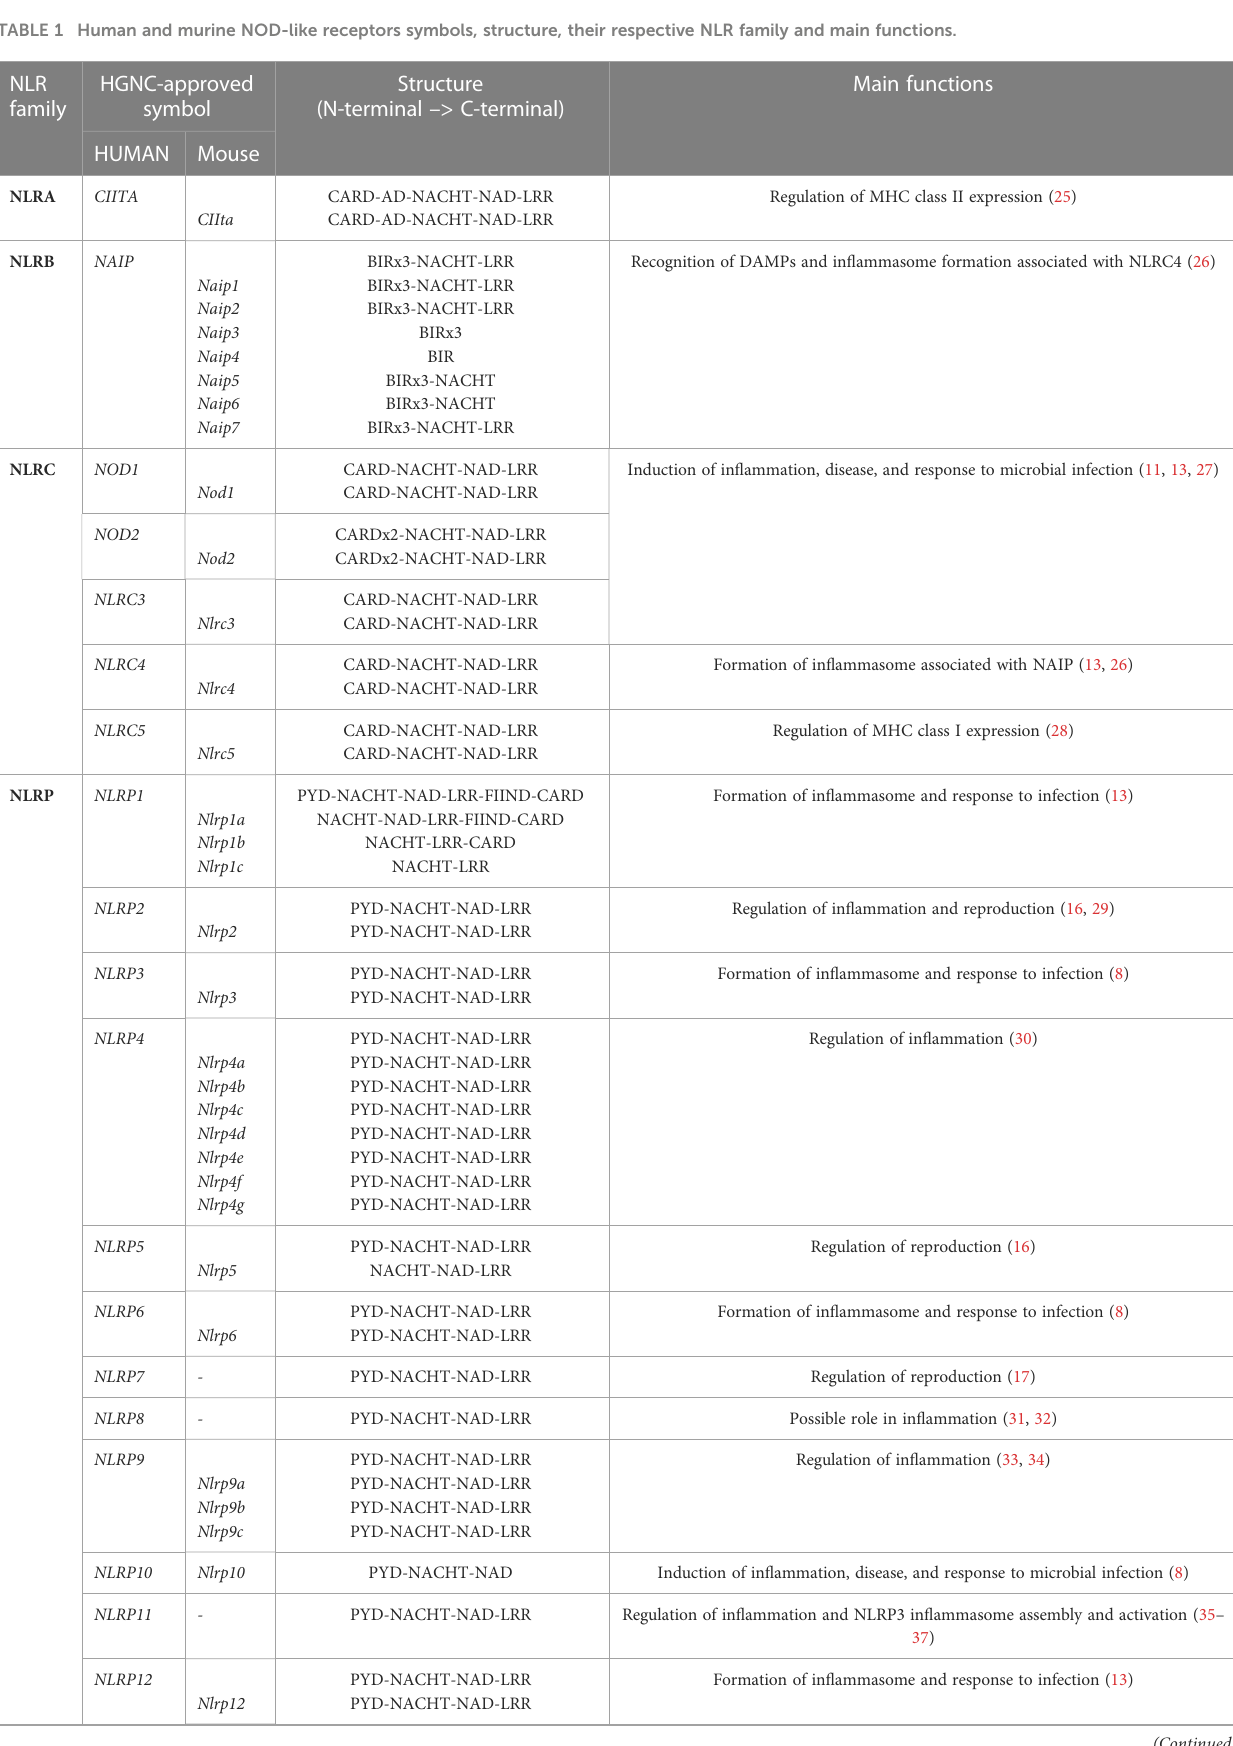
TABLE 1 Human and murine NOD-like receptors symbols, structure, their respective NLR family and main